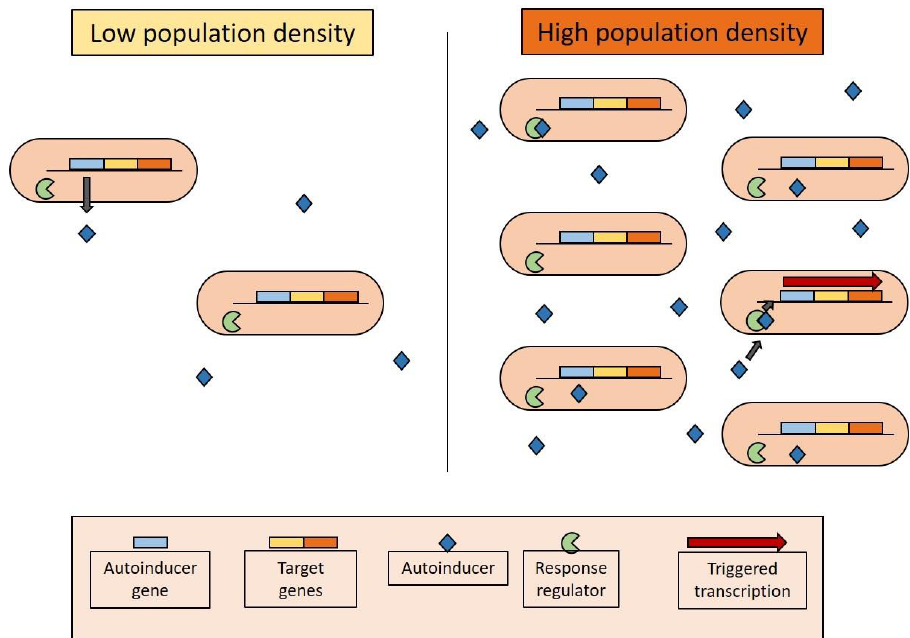
Figure 4. Quorum-sensing regulation mechanism.